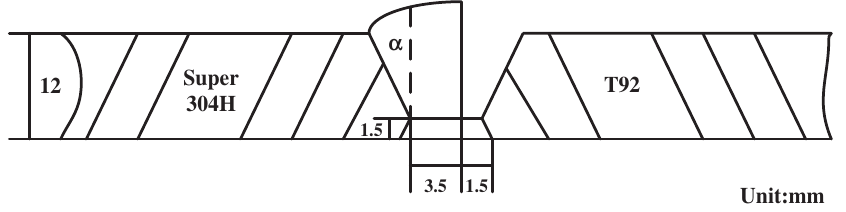
Figure 1: Schematic diagram of T92/Super 304H dissimilar weld joints.